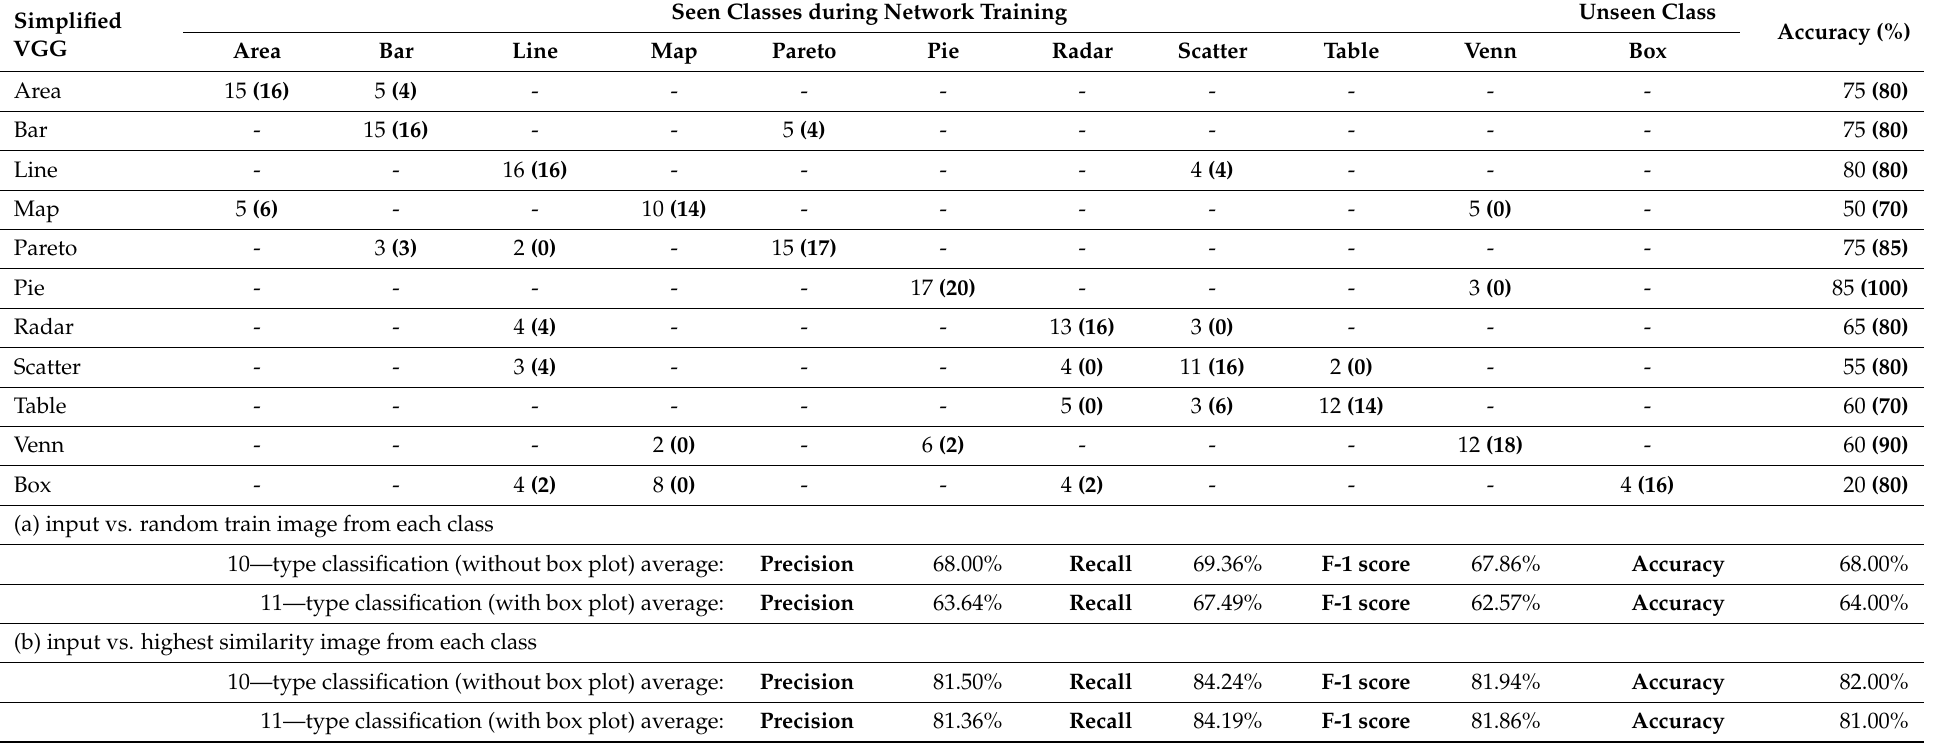
Table 6. There are two cases in a table: (a) input vs. random train image from each class; (b) input vs. highest similarity image from each class (shown in parenthesis). Each class can have a maximum of 20 correct